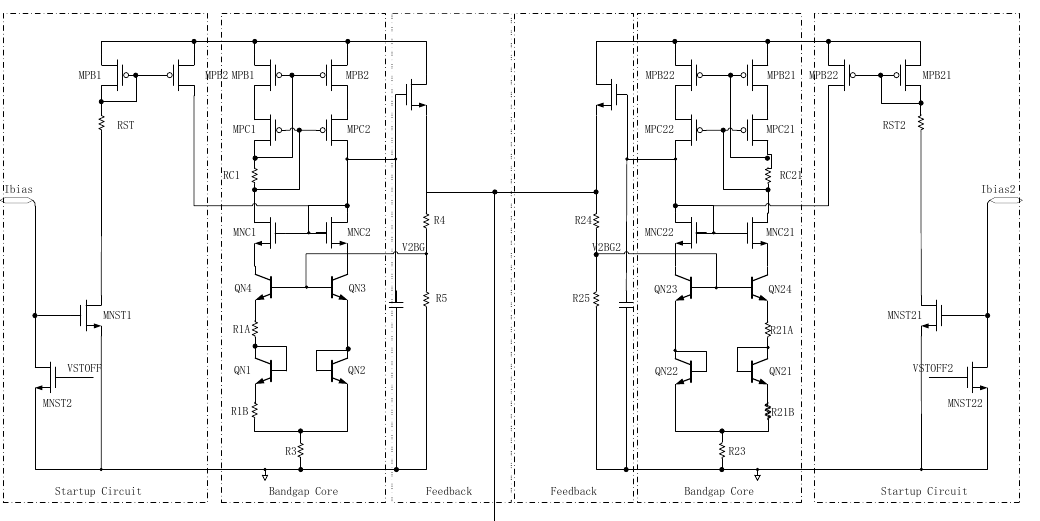
Figure 6. Proposed SPWBGR schematic.